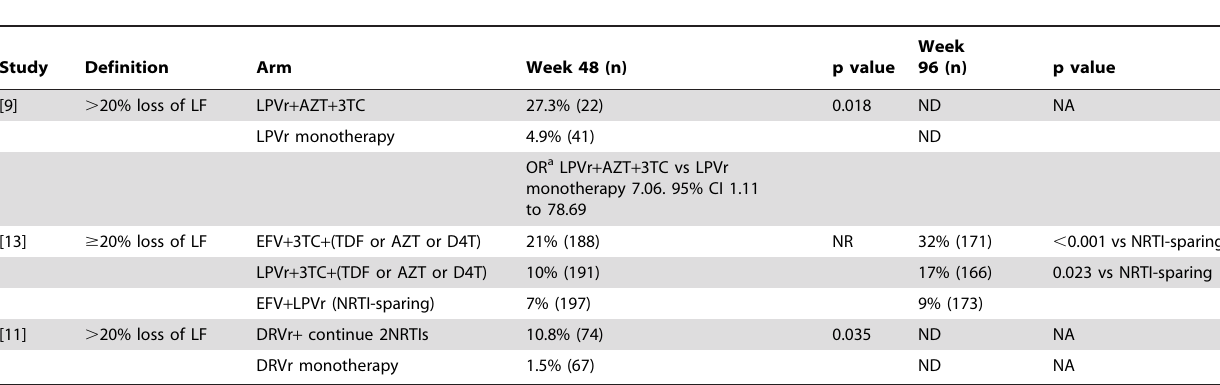
Table 7. Proportion of patients with peripheral lipoatrophy on DEXA scan: NRTI-containing regimens versus NRTI-sparing